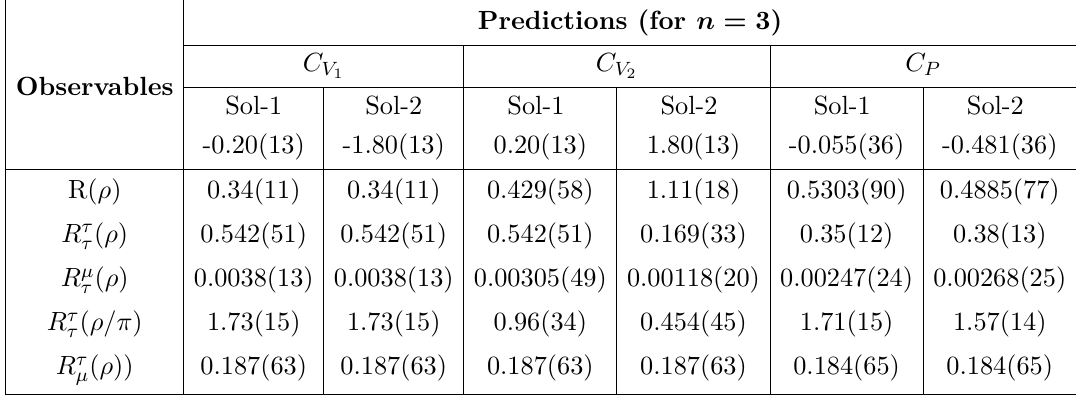
Figure 5. Variations of the observables R ( ρ ) , R τ one at a